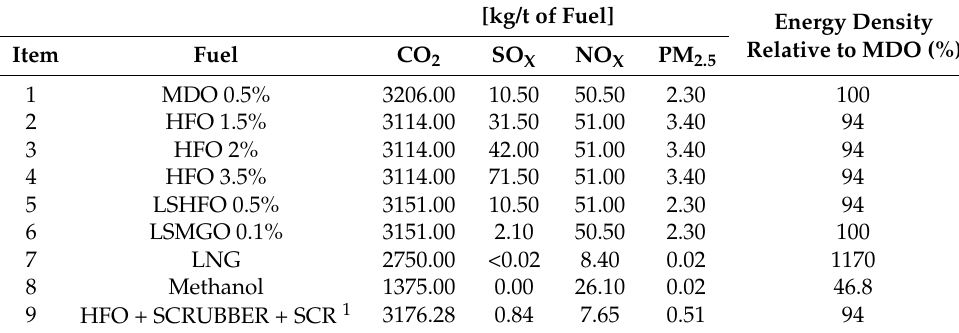
Table 3. Emissivity indices for selected marine fuels.